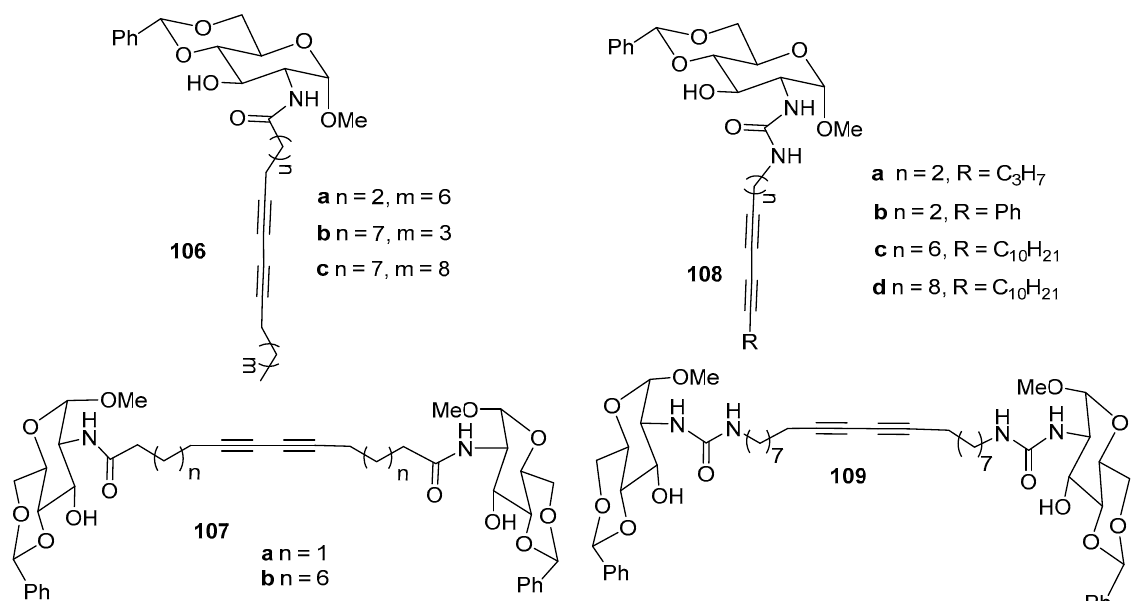
Figure 63. Structures of diacetylene containing amide and urea derivatives [38], n and m represent the number of repeating CH 2 unit.